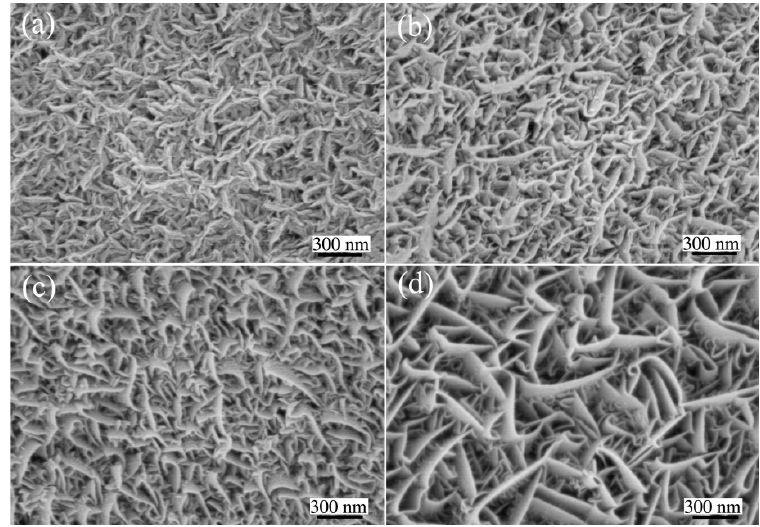
Figure 1. Surface scanning electron microscope (SEM) images of the WS 2 films deposited at different substrate temperature: ( a ) WS 2 -40; ( b ) WS 2 -25; ( c ) WS 2 -0; and ( d ) WS 2 -RT.